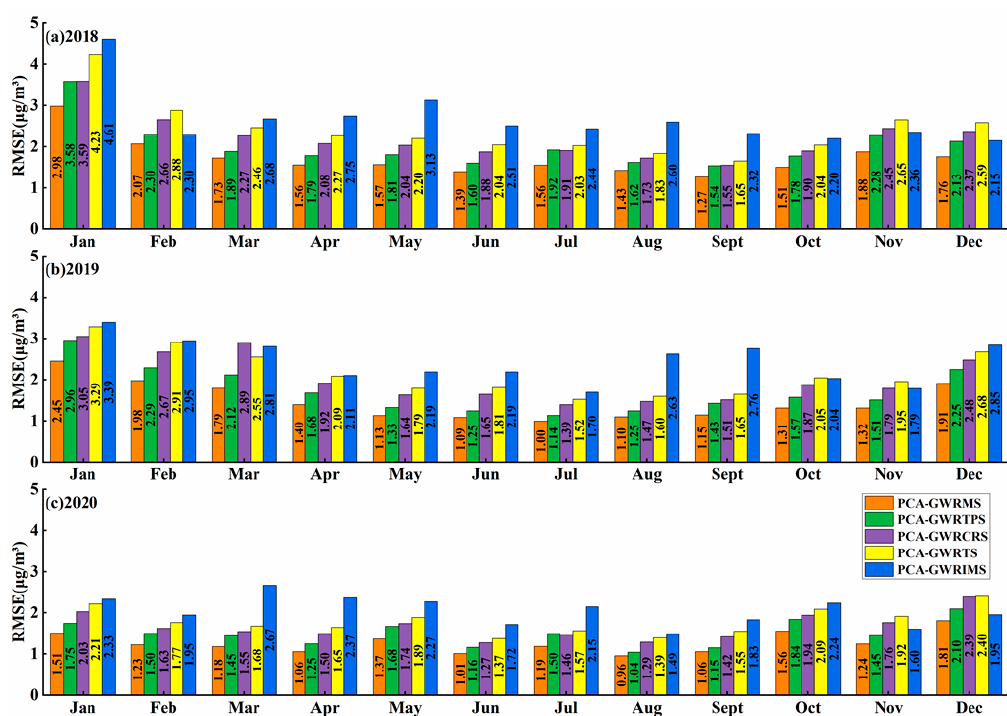
Figure 9. RMSE of cross-validation results after the residual correction of PM 2.5 estimates from PCA-GWR models for different months in ( a ) 2018, ( b ) 2019 and ( c ) 2020 using five interpolation methods (MS (orange), TPS (green), CRS (purple), TS (yellow), and IMS (blue)).